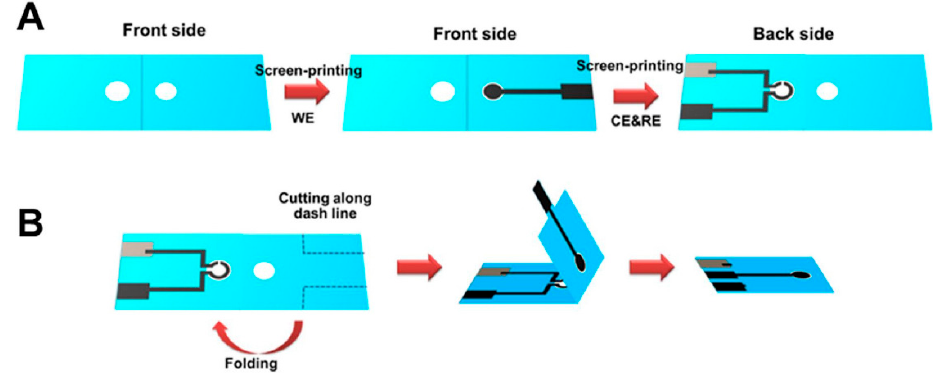
Figure 2. ( A ) Fabrication procedure of paper-based electrochemical device for human IFN- γ detection and ( B ) origami folding sequence. Reprinted from [22] with permission from and ( B ) origami folding sequence. Reprinted from [22] with permission from Elsevier.